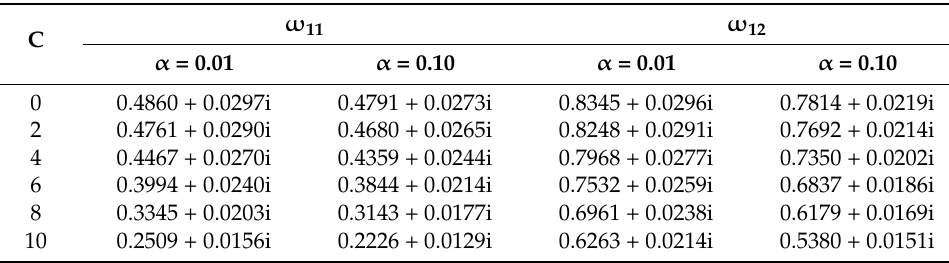
Table 2. Dimensionless natural frequencies for the axially-moving nanoplate resting on a viscoelastic foundation ( × 10 2